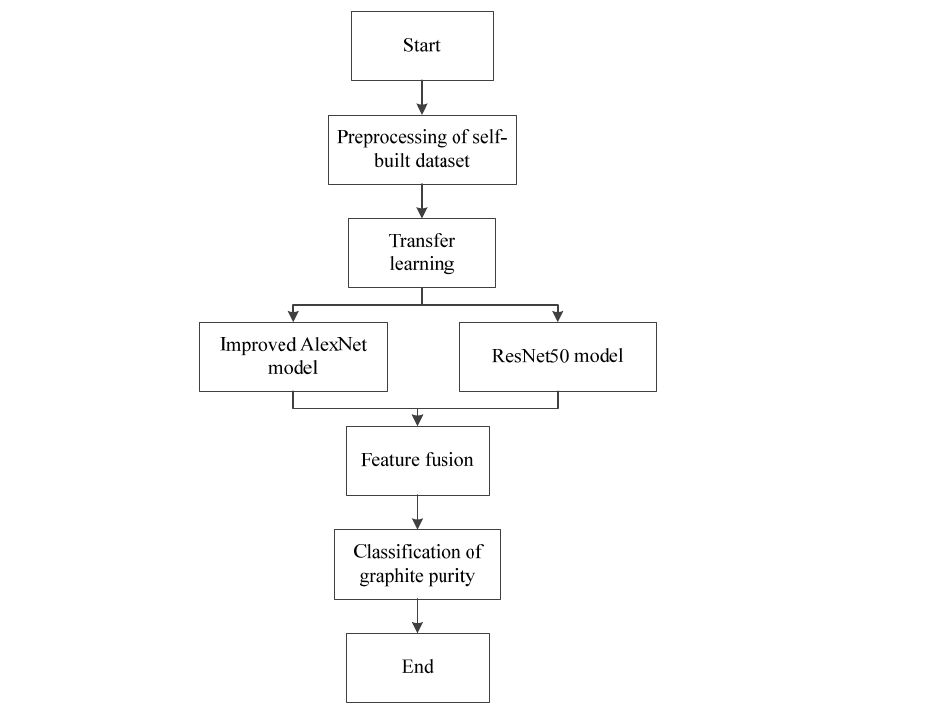
Figure 1. Overall framework of graphite purity identification algorithm.